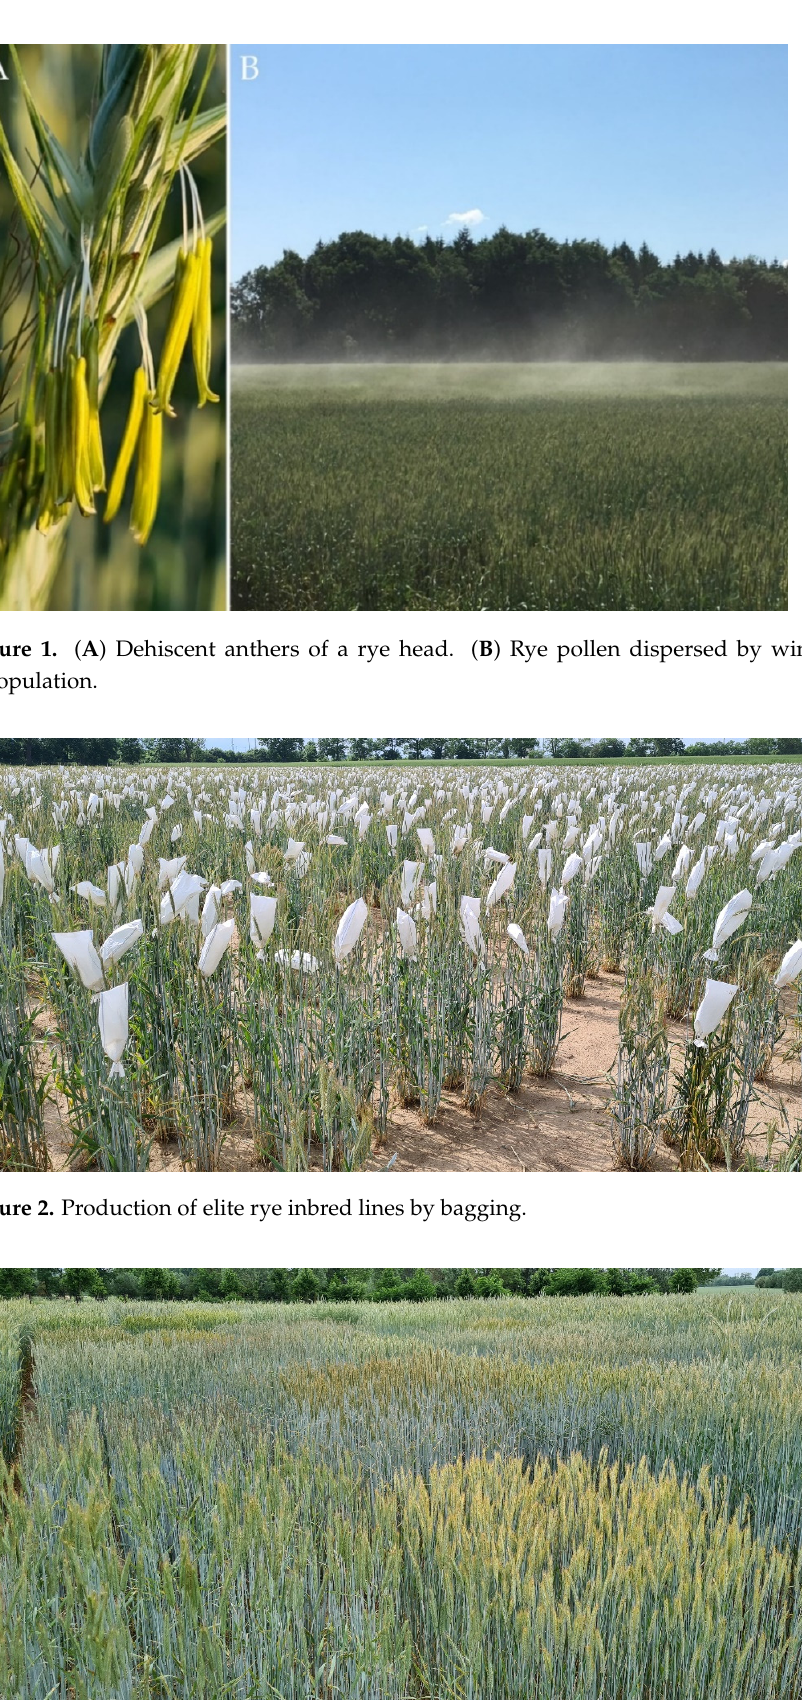
Figure 3. Inbred lines enable to assess and manage the genetic diversity of rye.